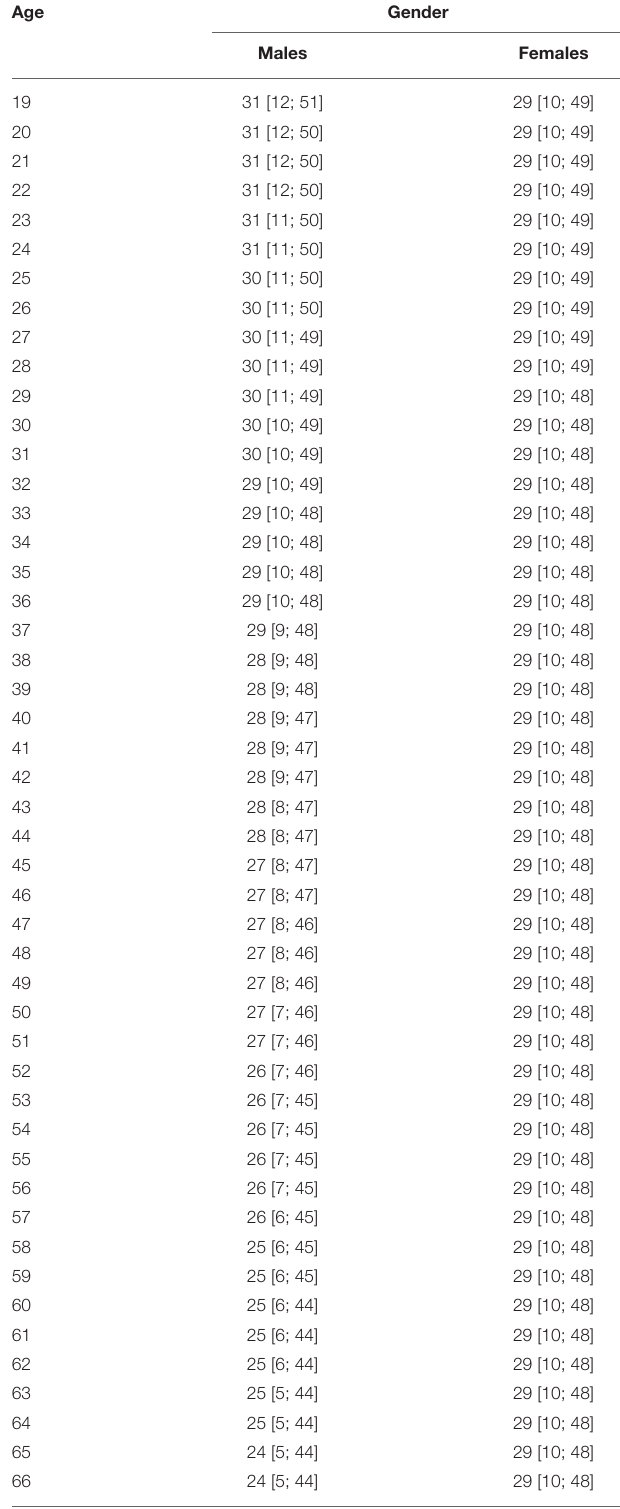
TABLE 4 | Mean value and 90% CIs of expected loneliness distress as a function of gender and